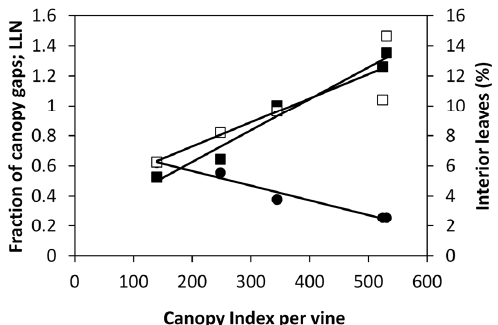
Figure 9. Correlation of Canopy Index vs. fraction of canopy gaps, LLN and fraction of interior leaves for data pooled over vines. Each point represents a measuring date. Equations of linear models were: y = − 0.001 x + 0.761, R 2 = 0.97 for fraction of canopy gaps ( • ); y = 0.0021 x + 0.2065, R 2 = 0.97 for LLN ( (cid:4) ), y = 0.0161 x + 4.0828, R 2 = 0.78 for fraction of interior leaves ( (cid:3) ).